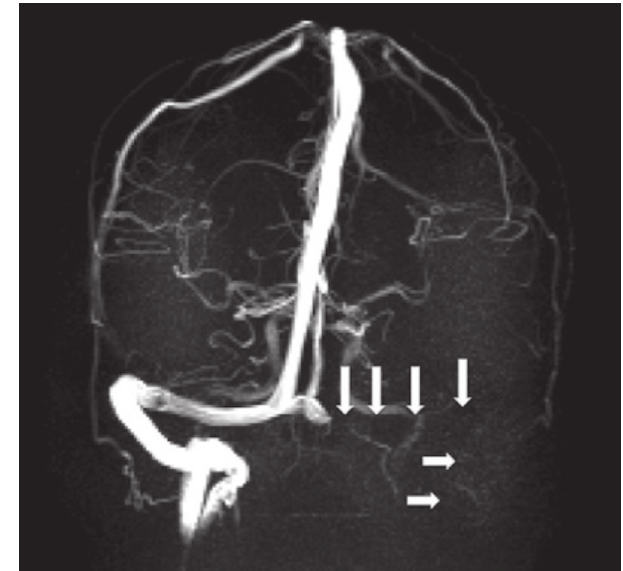
Figure 1) Magnetic resonance imaging. Axial T2 image showing heterogen- ous collection at the left temporal lobe consistent with a large intraparen- chymal hemmorhage containing both subacute and acute blood. Moderate surrounding vasogenic edema (arrows)